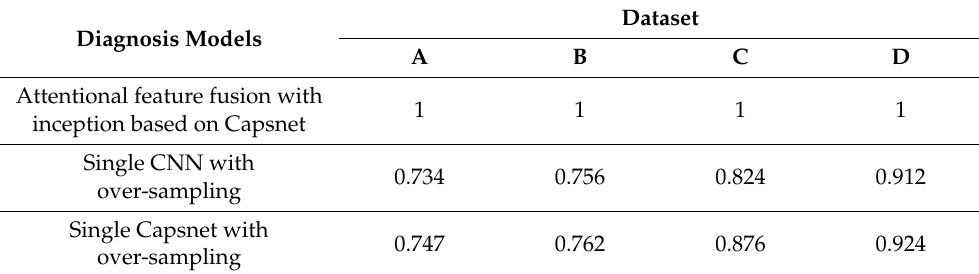
Table 5. Comparison with other data augmentation using different training